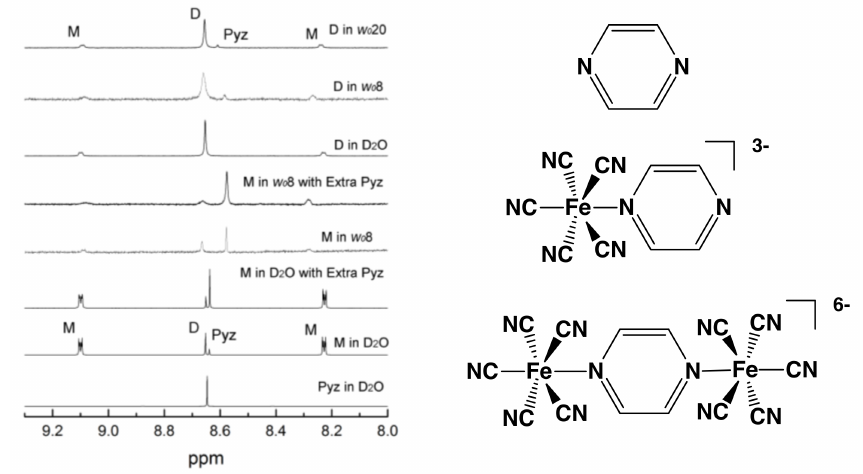
Figure 5. 1 H-NMR spectra recorded at 300 MHz of 20 mM M (or D) in aqueous solution, or in 0.75 M AOT /isooctane RMs. Starting from the bottom: Pyz in D 2 O, M in D 2 O, M in D 2 O spiked with Pyz; RM size w 0 8 and RM spiked with Pyz; D in D 2 O; D in RM w 0 8 and w 0 20. The structures of pyrazine (abbreviated Pyr), the monomeric pentacyano(pyrazine)ferrate(II) [Fe(CN) 5 ] 3 − (abbreviated M) and the dimeric [Fe(CN) 5 (pyrazine)Fe(CN) 5 ] 6 − (abbreviated D) are